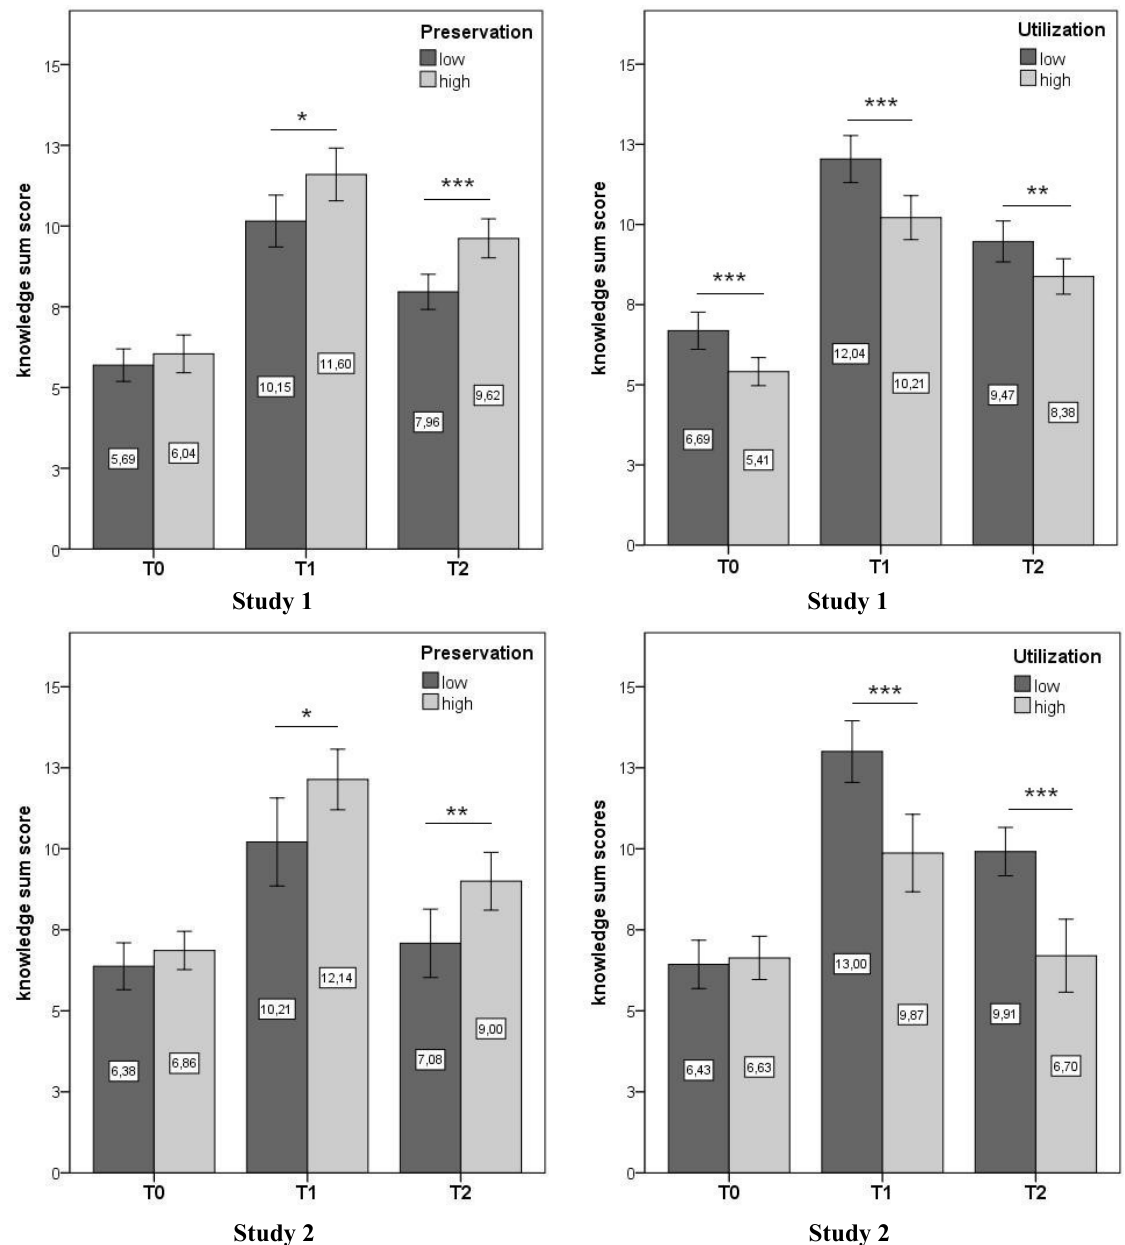
Figure 3. Knowledge sum scores of both treatments classified after participants’ affiliation to the extreme groups (high or low Utilization or Preservation scores); error bars show 95% CI; * p ≤ 0.05, ** p ≤ 0.01; *** p ≤ 0.001.